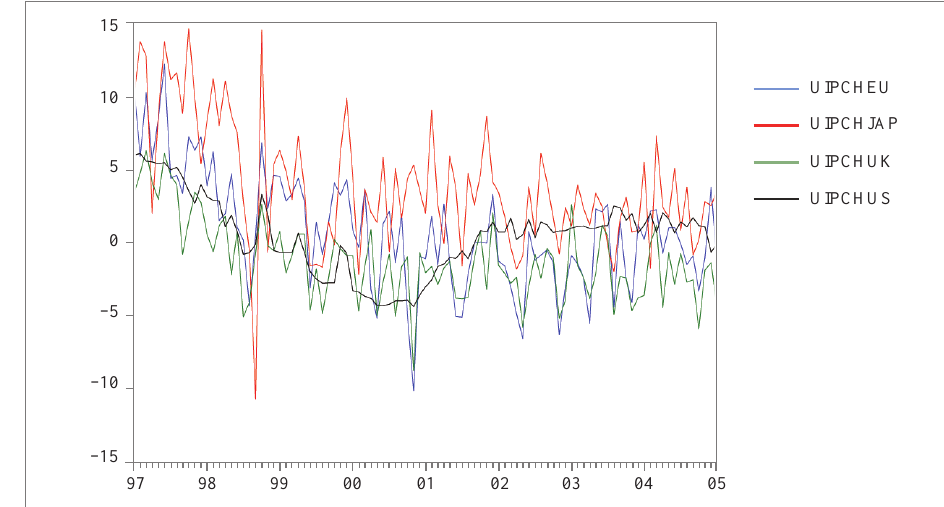
fig. 2. Uncovered interest rate parity